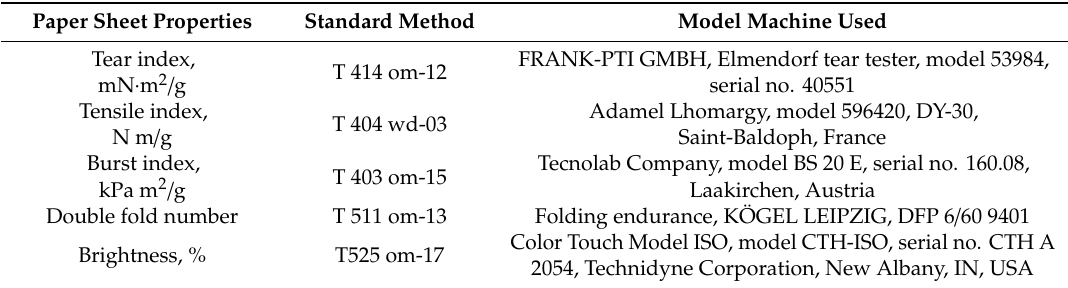
Table 2. Standard test methods used for mechanical strength and optical properties of bleached initial pulp obtained from samples of M. sinclairii and E. camaldulensis wood